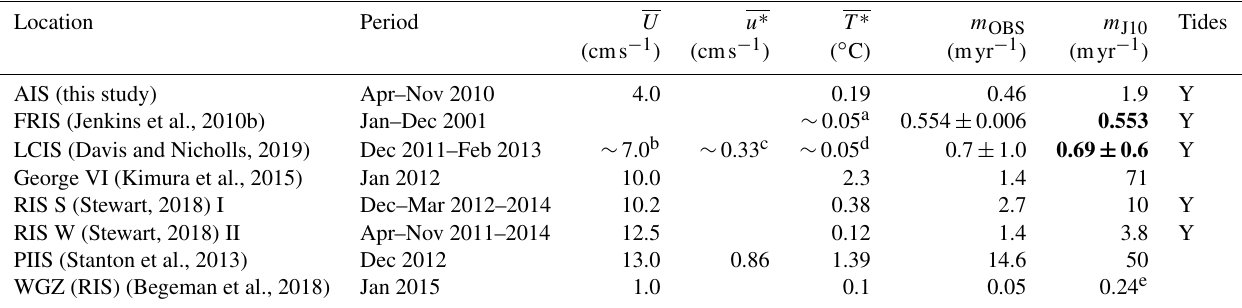
a Value obtained from visual inspection of Fig. 4 of Jenkins et al. (2010b). Value should be considered approximate only. b Calculated from Fig. 3 of Davis and Nicholls (2019) (upper instrument). Value should be considered approximate only. c Calculated from U and observed drag coefficient C d = 0.0022. d Mixed-layer temperature